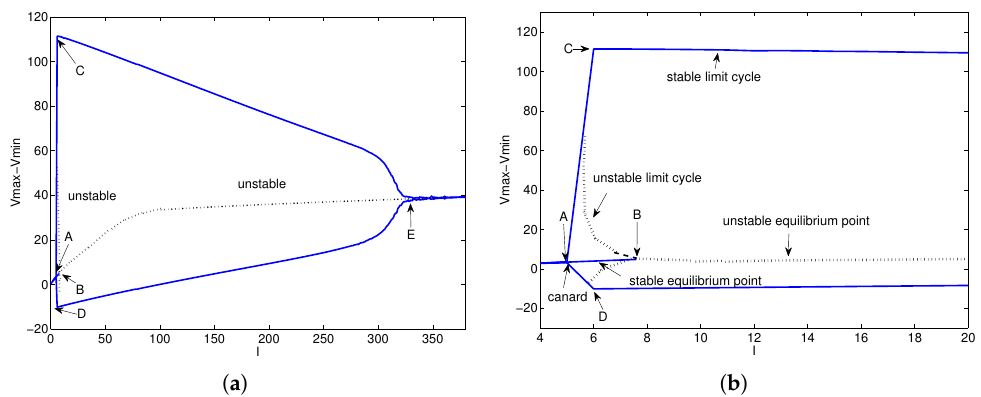
Figure 4. Bifurcation diagram for parameter I . ( a ) The I–V max , I–V min curves and equilibrium points of model (28). ( b ) A locally enlarged view of ( a ) near Hopf point B.